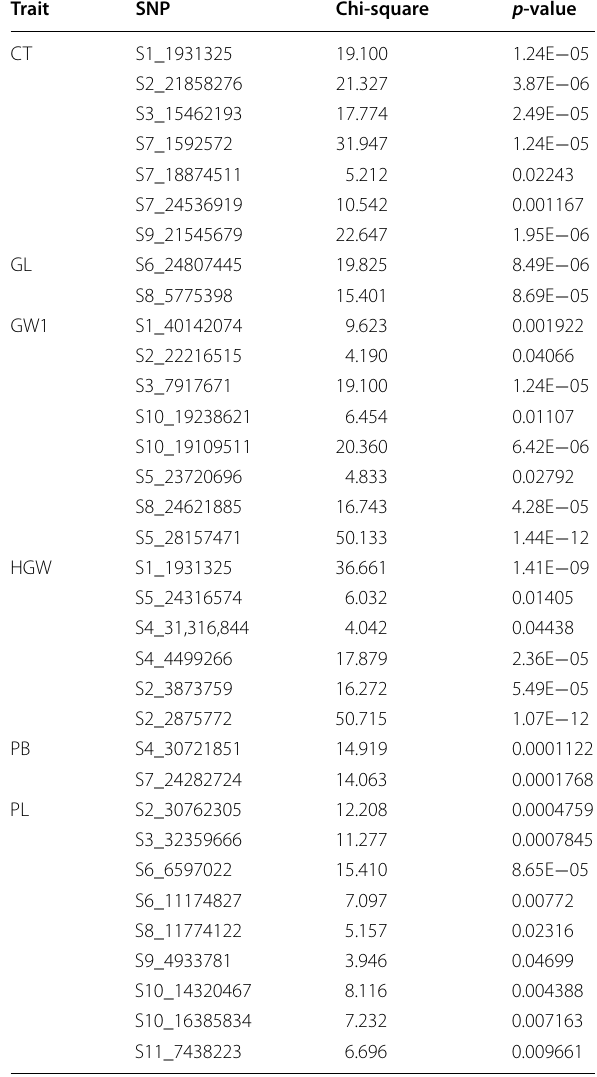
Table 5 List of MTAs with significant differences between allelic effects on the basis of Kruskal–Wallis test